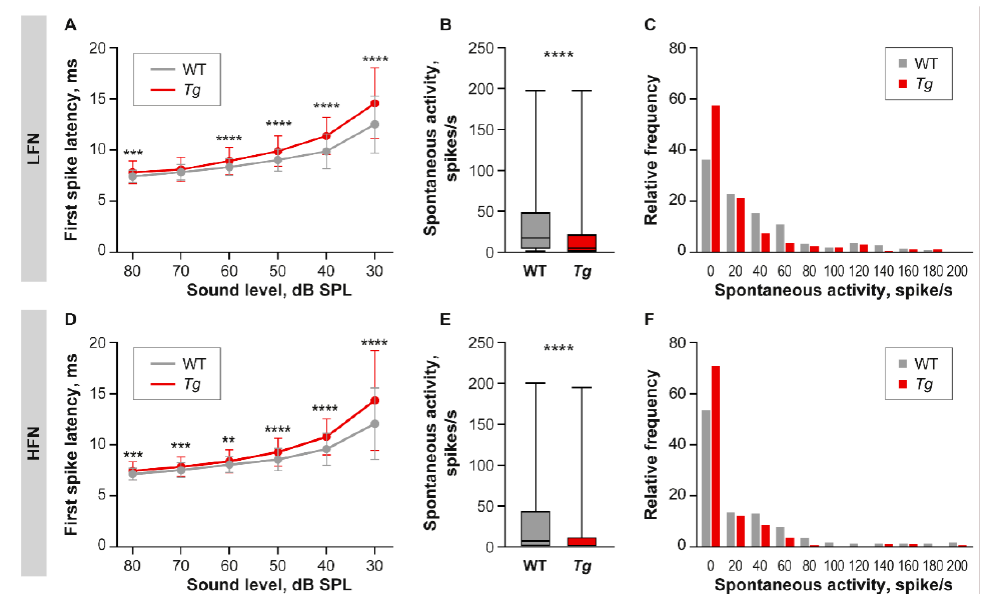
Figure 5. First spike latency and spontaneous activity. ( A , D ) FSL as a function of sound intensity for LFN ( A ) and HFN ( D ) in WT and Tg IC. Repeated measures two-way ANOVA, Uncorrected Fisher’s LSD post-hoc test, ** p < 0.01, *** < 0.001, **** p < 0.0001. ( B , E ) Box and whiskers plots showing distribution of spontaneous activity values in LFN ( B ) and HFN ( E ). Median with interquartile range and extremes, Mann-Whitney test, *** <0.001, **** p < 0.0001. ( C , F ) Histogram showing distribution of spontaneous activity values in LFN ( C ) and HFN ( F ).